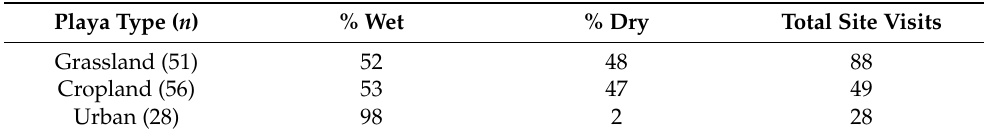
Figure 5. Non-metric, multidimensional scaling ordination plot with 95% confidence ellipses of the centroids in an ordination space of odonate species occurrences at three types of playa environments (red circles = grassland; green triangles = cropland; blue diamonds = urban) across the Texas panhandle (United States), 2003–2020. Table 2. Frequency of the occurrence of water in playas sampled in the Texas panhandle (United States),